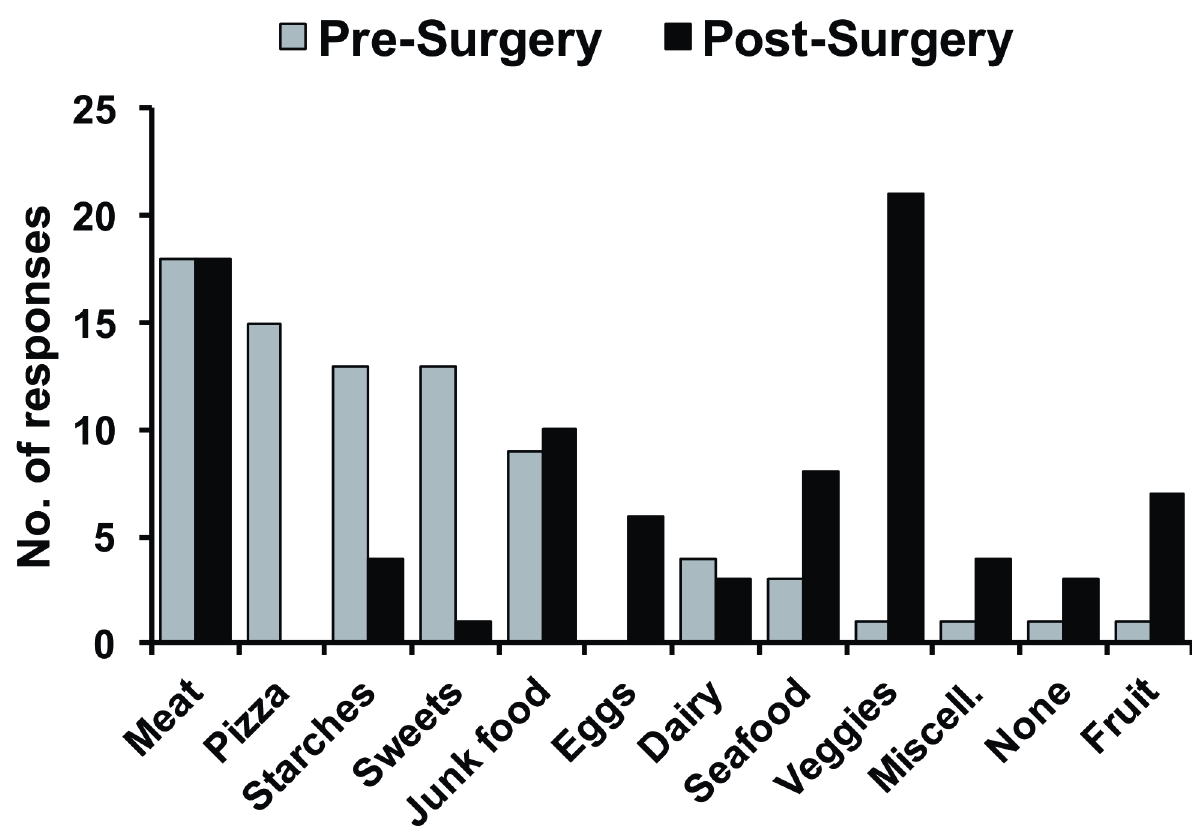
Fig 3. Responses to open ended question about favorite foods prior to and after